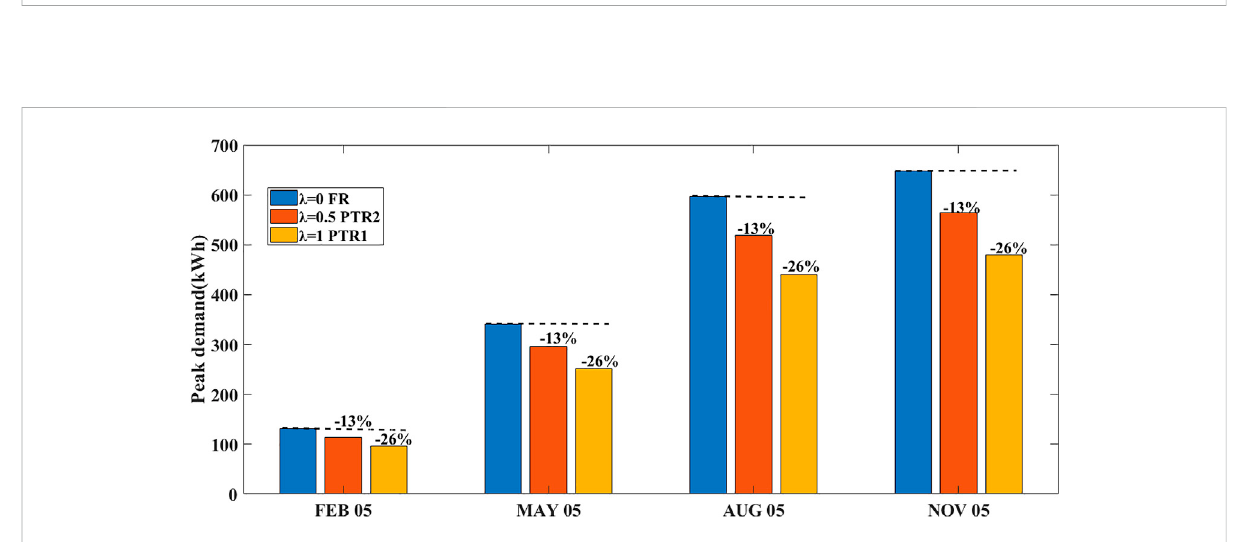
FIGURE 13 Percentage change in peak demand for all seasons and all values of loss